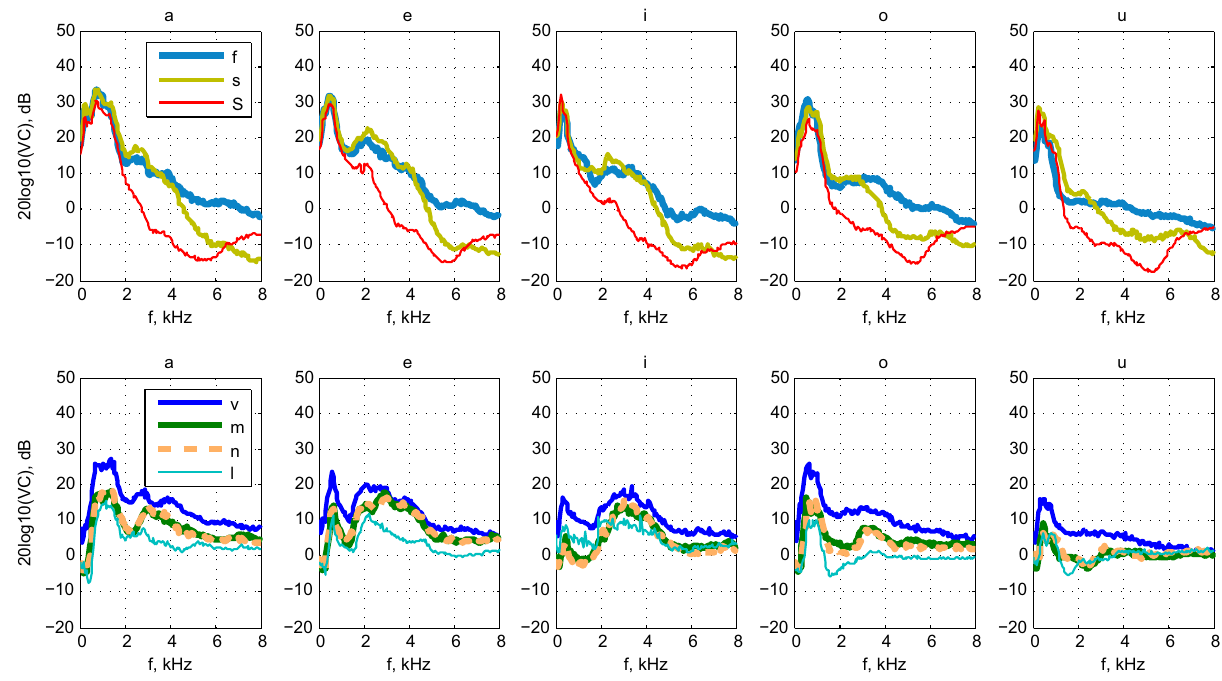
Figure 10. VCV logatomes: average vowel – consonant spectra